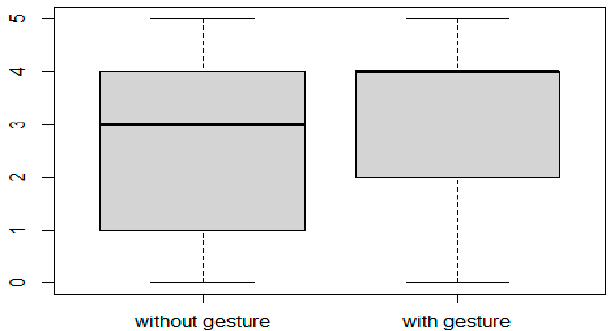
Figure 4. Box plot for testing results in the Receptive Post-Test 2 condition.